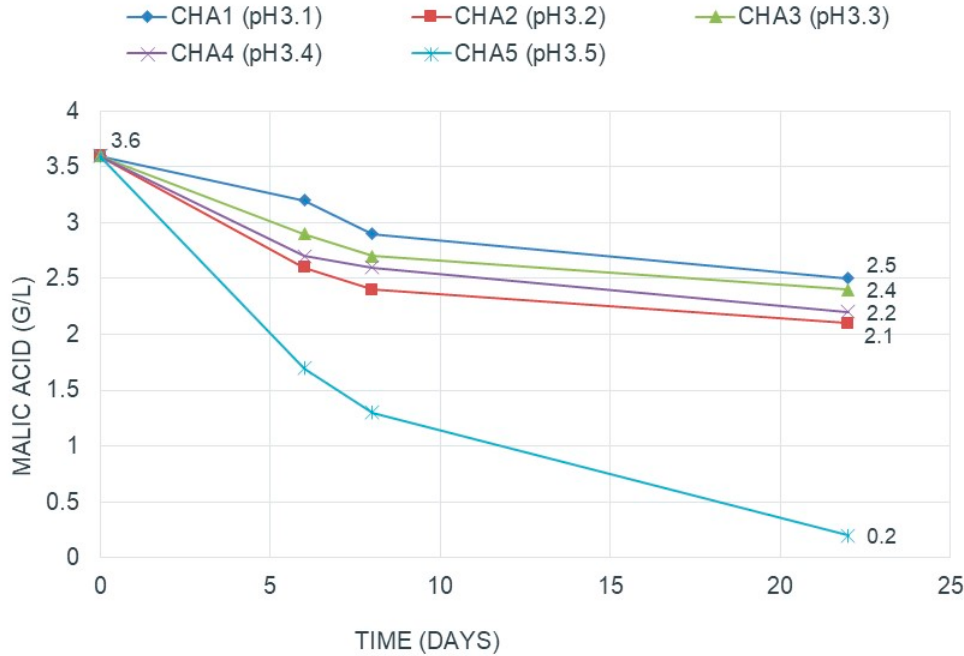
Figure 7. Kinetics of malic acid degradation in a 2017 Chardonnay (South-France) after co-inoculation with L. plantarum (ML-Prime ™ ) depending on the pH. Initial must analyses: malic acid concentration 3.6 g / L, total sugars 189 g / L, potential alcohol 11.2% ( v / v ), 7.56 g / L total acidity (in tartaric acid), nitrogen 193 mg / L (Internal laboratory trials Lallemand SAS).